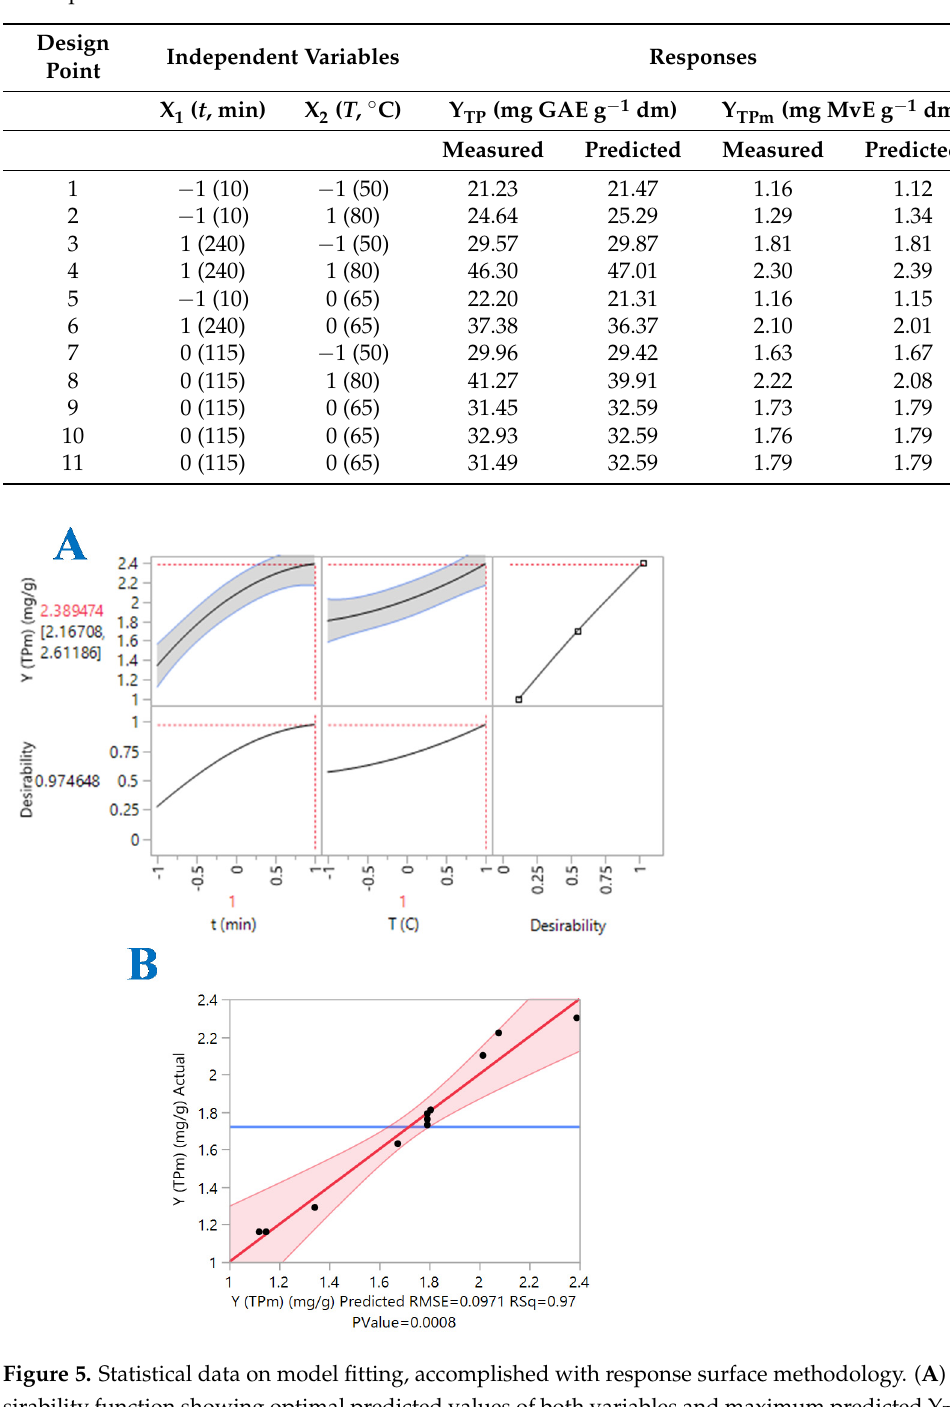
Table 3. Points of the experimental design with the corresponding measured and predicted values of the responses.